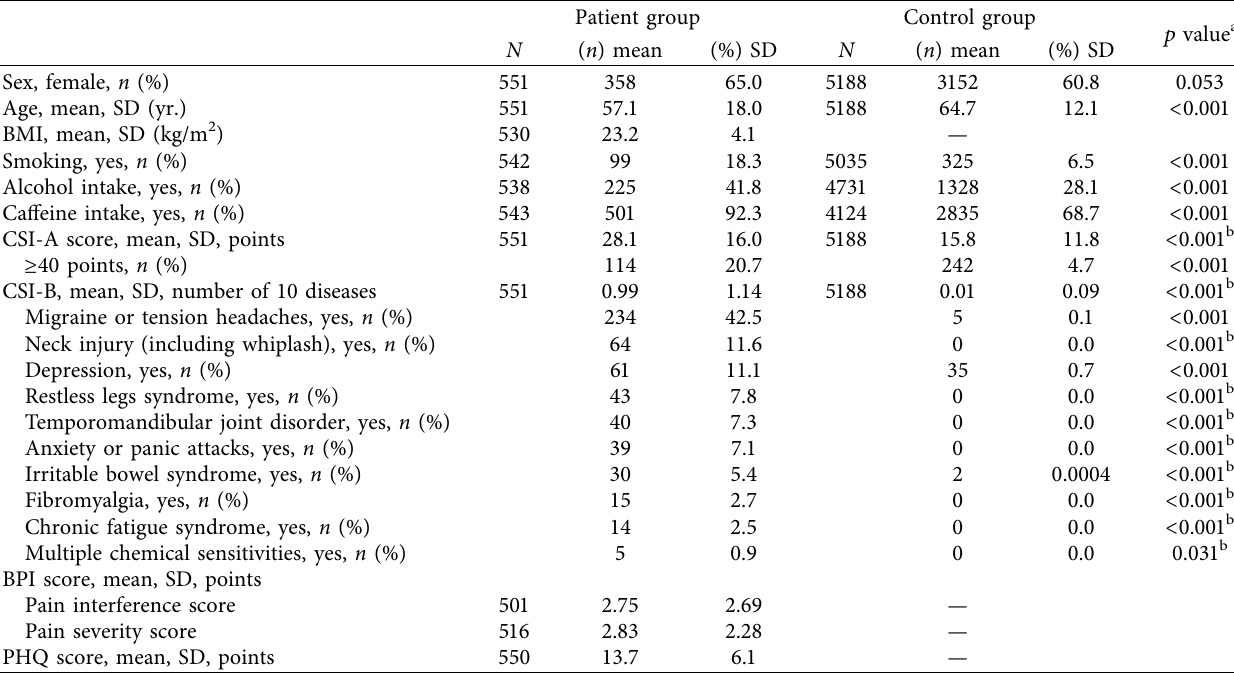
Table 1: Characteristics of the patient and healthy control group.